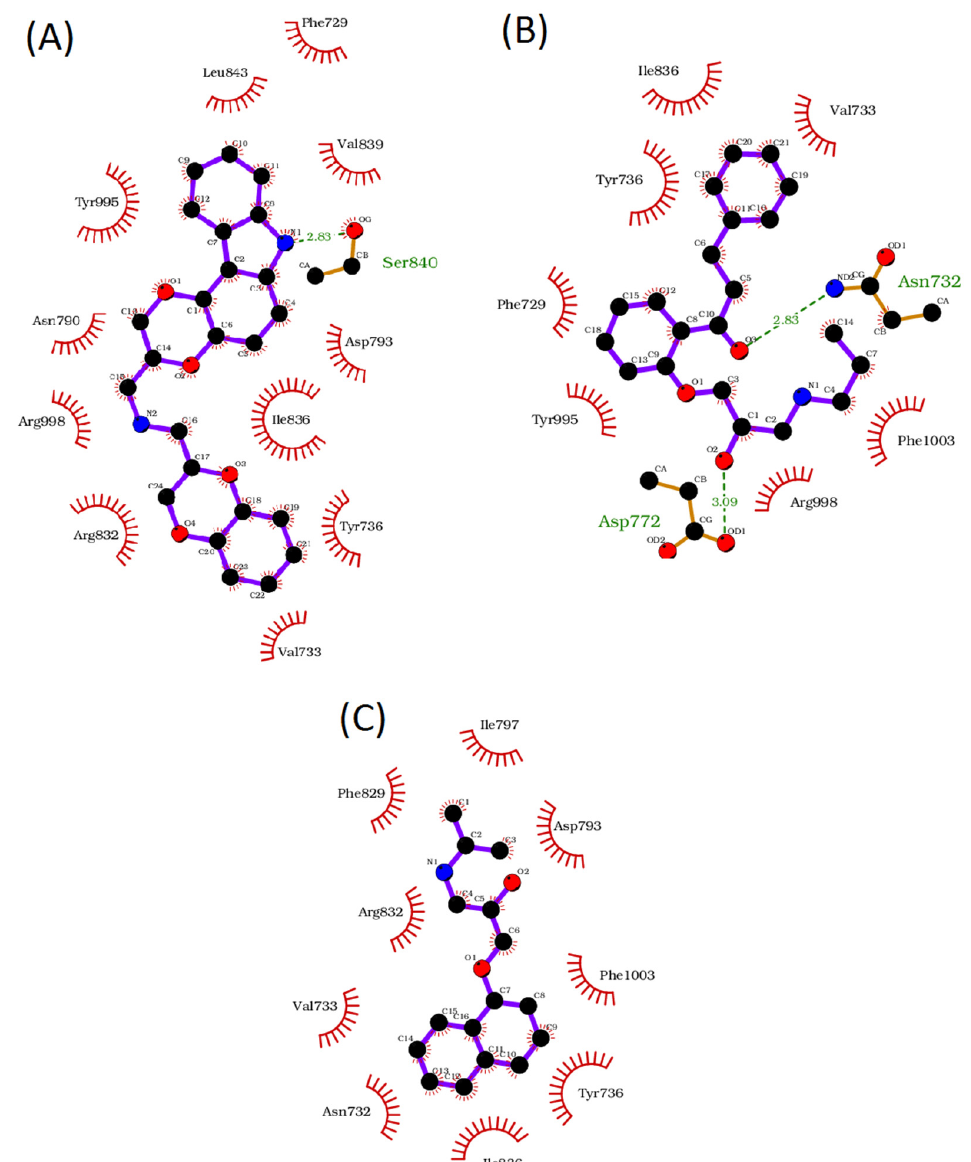
Figure 4. 2D depiction of the intermolecular interactions between TRPM8 and carvedilol ( A ), propafenone ( B ), and propranolol ( C ). The 2D plots were generated by LigPlot + . Hydrogen bonds are shown as green dotted lines, while the red spoked arches represent hydrophobic contacts of residues with each drug. In the represented structures, carbon, oxygen, flour, and nitrogen are in black, red, green, and blue, respectively.